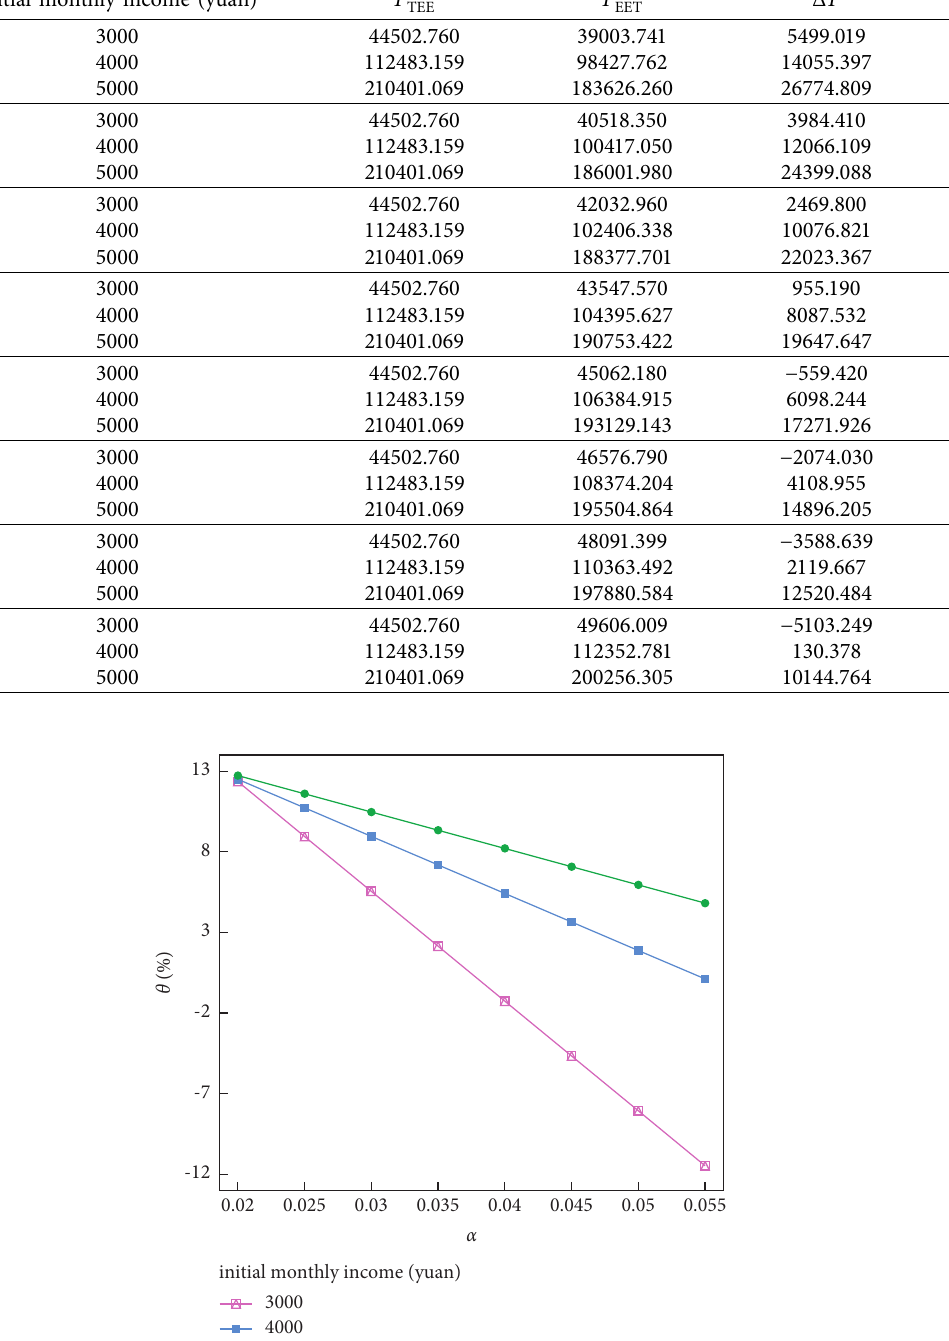
Table 3: Tax difference and tax-saving rate of the low-income group under different insurance amount tax rates. α